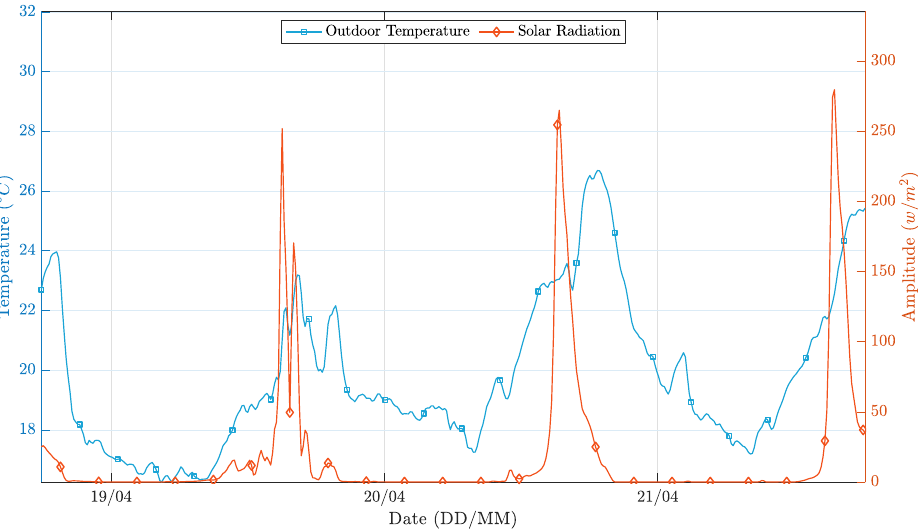
Figure 13. External environment conditions during test time PP